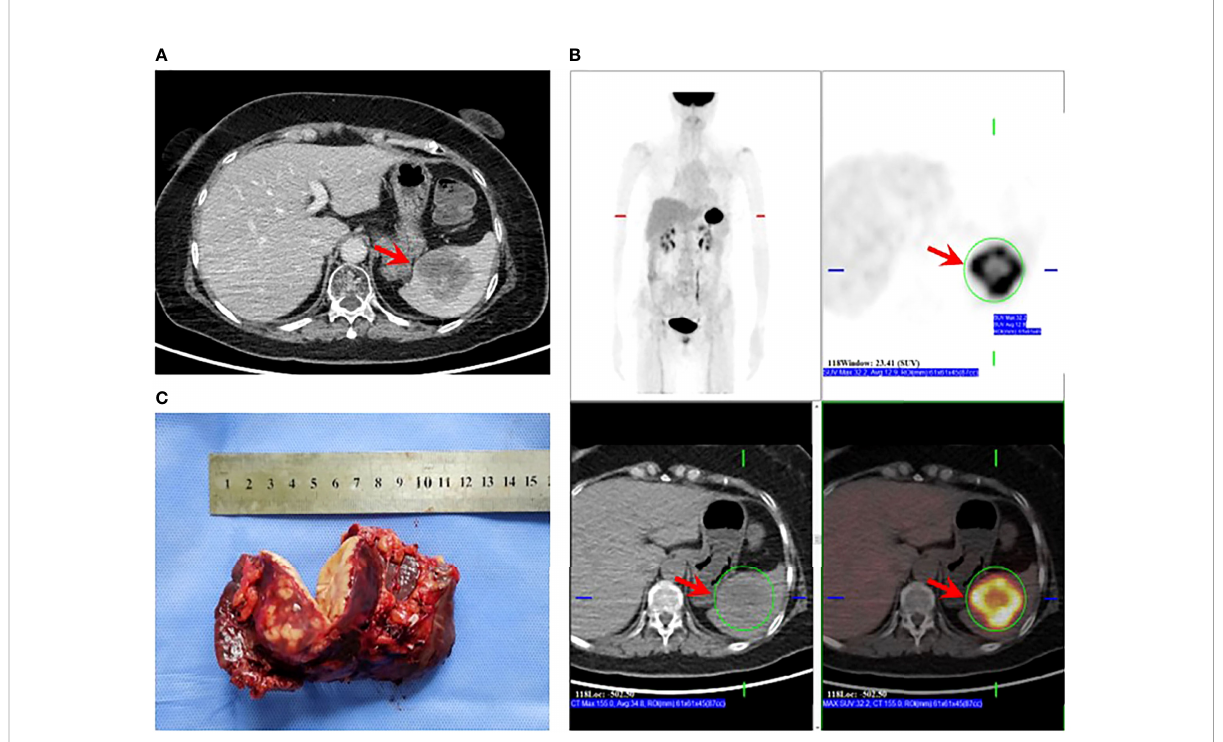
FIGURE 2 Splenectomy for solitary splenic metastasis. (A) CT showing a hypodense mass in the spleen that was heterogeneously enhanced after an enhanced scan (arrow). (B) PET/CT showing evidently increased FDG uptake of the splenic mass (arrow); SUVmax: 32.2; no sign of malignant tumor metabolism in the remaining body parts. (C) Specimen obtained